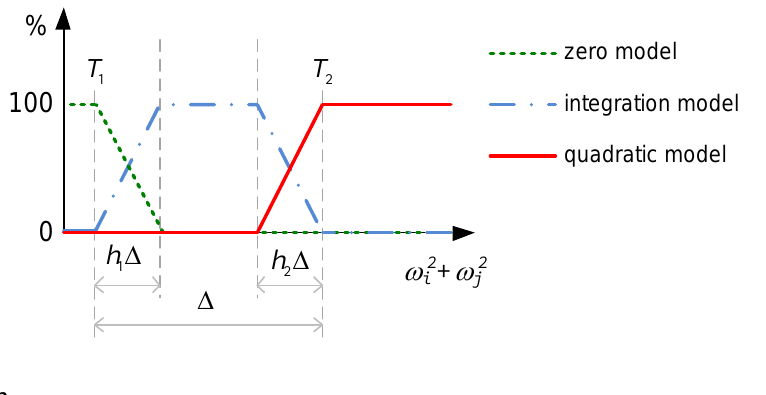
Figure 6. Defined probabilities of the interacted three